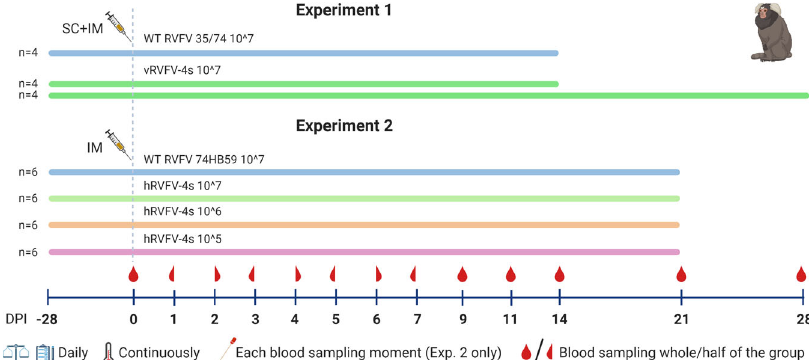
Fig. 1 Schematic representation of the experimental design. Marmosets of experiment 1 were inoculated with vRVFV-4s and in experiment 2 with hRVFV-4s with the indicated dose and route. In both experiments, control animals were inoculated with the wild-type parent strains; for vRVFV-4s this is strain 35/74 and for hRVFV-4s this is 74HB59. Blood samples were taken regularly as indicated, and body temperatures were monitored continuously by an abdominal implanted AniPillV2. Oral and rectal swabs were taken only during experiment